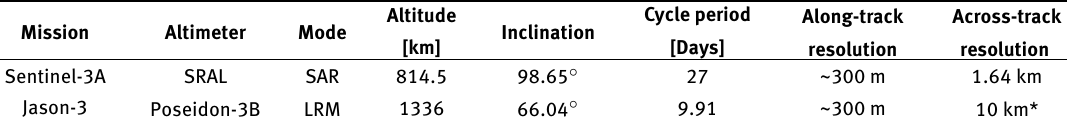
Table 2: The used SA mission’s specifications Mission Altimeter Mode Sentinel-3A SRAL SAR 814.5 98.65 ◦ 27 ~300 m 1.64 km Jason-3 Poseidon-3B LRM 1336 66.04 ◦